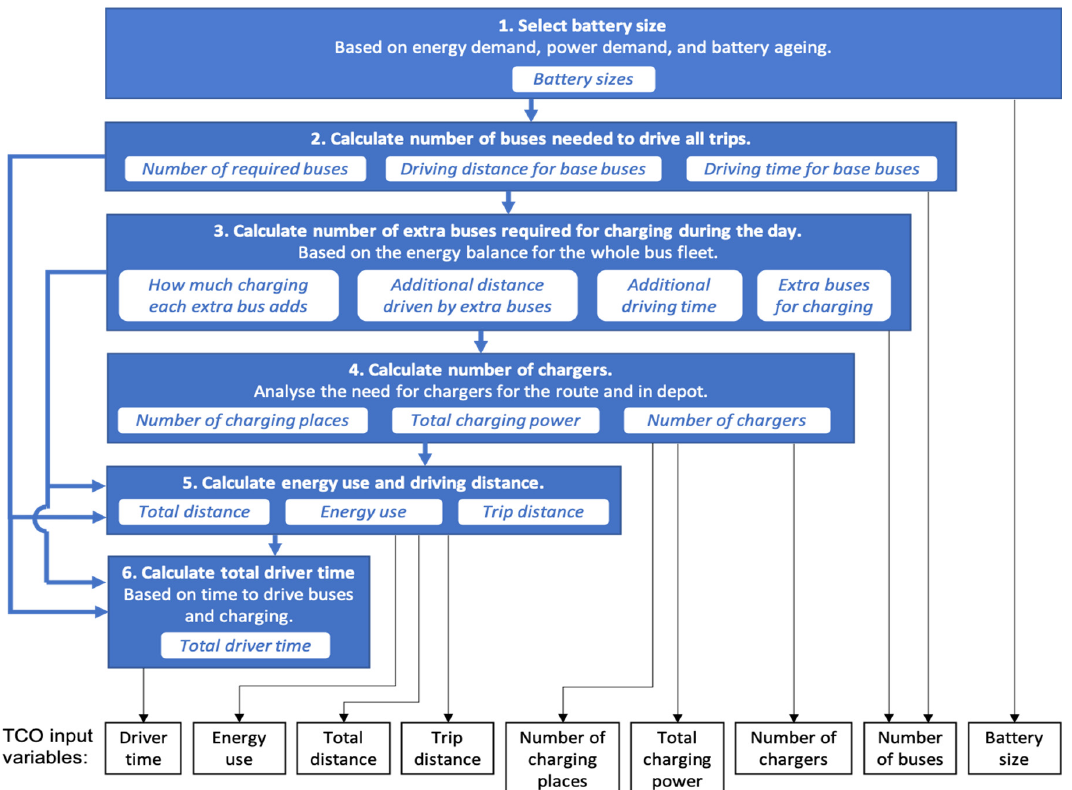
Figure 3. Steps 1–6 for how to calculate the nine TCO input variables, and information flow between these steps (to the left). The white boxes show some of the key variables calculated in different steps and the output variables.